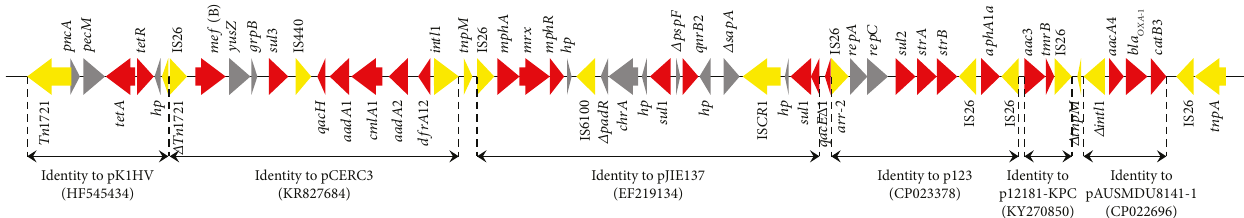
Figure 3: Schematic representation of the MDR region of plasmid pR46-270. Red arrows indicate resistance genes, yellow arrows indicate mobile genetic elements, and gray arrows indicate genes with other functions. Truncated genes are indicated by the “ Δ ”